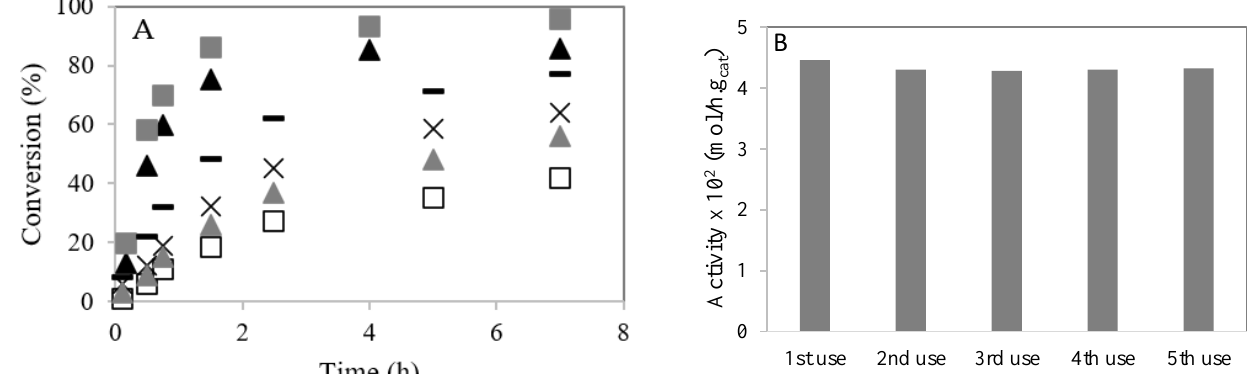
Figure 7. Esterification of caprylic acid with methanol or ethanol over 4–CH–SO 3 H catalyst: ( A ) effect of temperature. Conversion (%) versus time (h): ( ) reaction with methanol at 60 °C (m = 0.2 g); ( ) reaction with methanol at 60 °C (m = 0.3 g); ( ) reaction with ethanol at 60 °C (m = 0.2 g); ( ) reaction with ethanol at 60 °C (m = 0.3 g); (x) reaction with ethanol at 80 °C (m = 0.2 g); (−) reaction with ethanol at 80 °C (m = 0.3 g); ( B ) stability studies of the 4–CH–SO 3 H catalyst on esterification of caprylic acid with methanol.